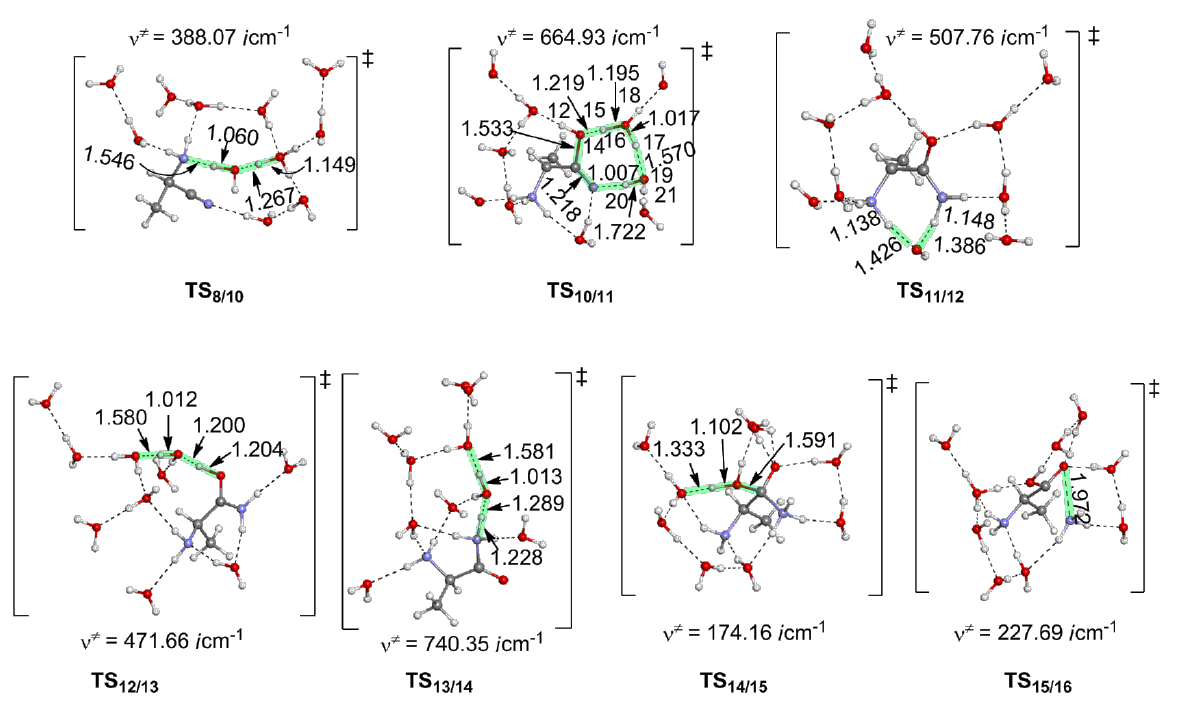
Figure 5: Geometries of transition states along the most favorable route from 2-aminonitrile 8 to 2-amino acid 16 .